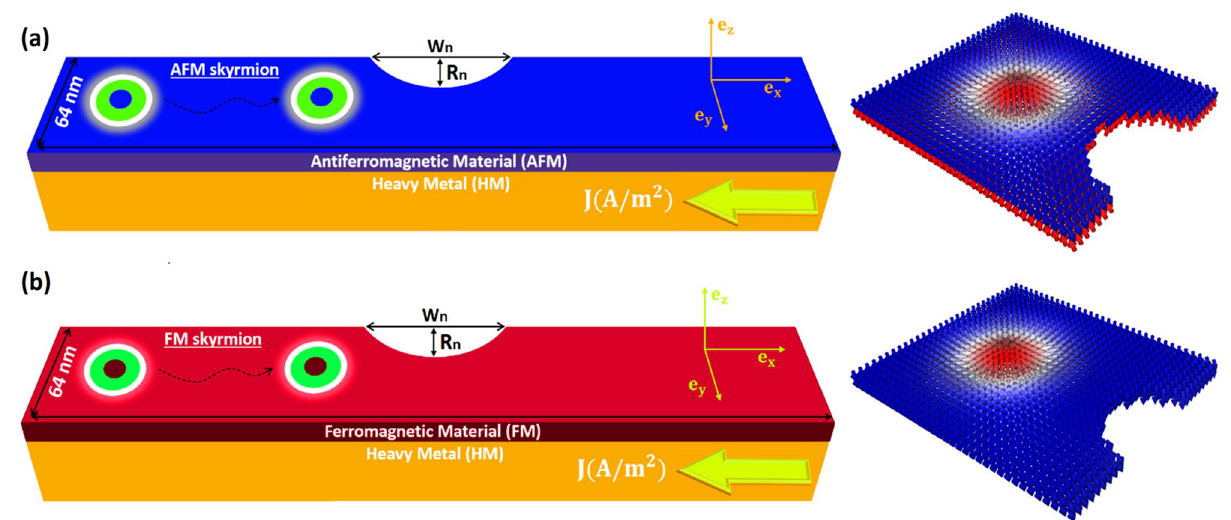
Figure 2. Illustration of two bilayer systems consisting of AFM/HM and FM/HM designed as a racetrack memory notched at the center and traversed by an electric current along the